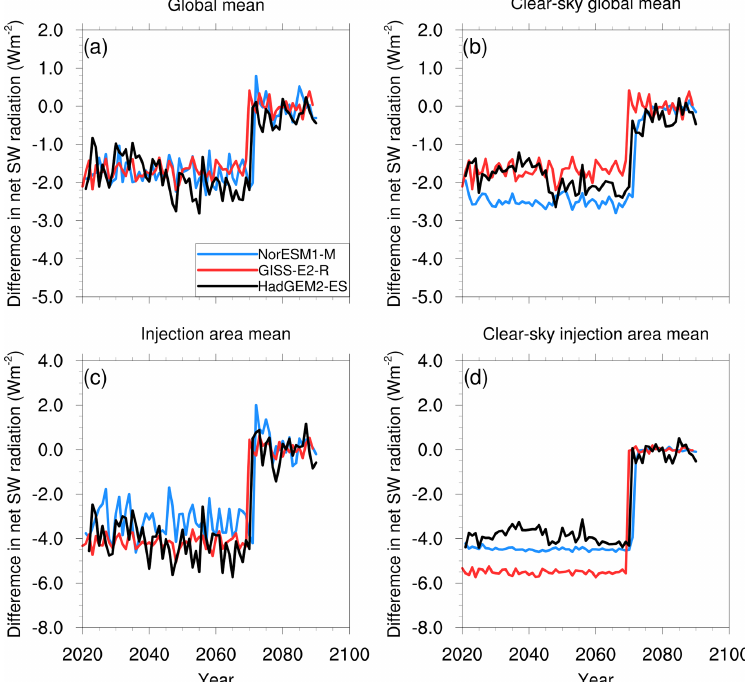
Figure 11. Difference in net SW radiation at the TOA between G4sea-salt and RCP4.5 (a) global mean, (b) clear-sky global mean, (c) injection area mean, and (d) clear-sky injection area mean. The colours denote NorESM1-M (blue), GISS-E2-R (red), and HadGEM2-ES (black). Only grid cells over ocean have been included in the mean values representative of the injection